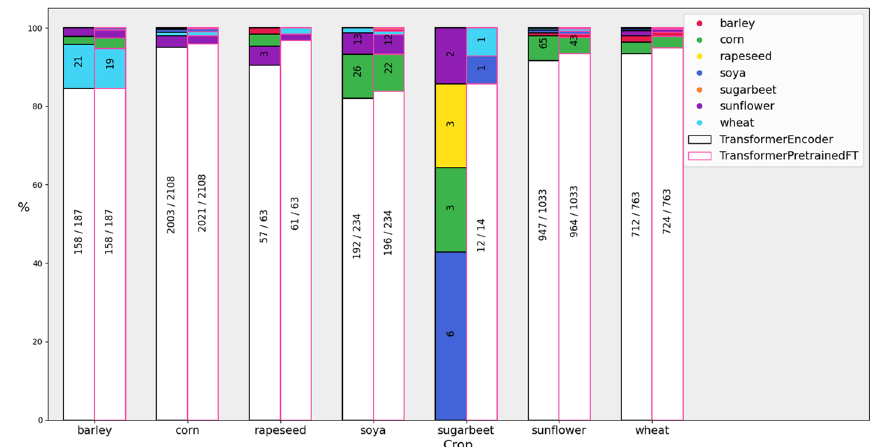
Fig. 8 Comparison of class errors and its distribution, for BMP and PFT